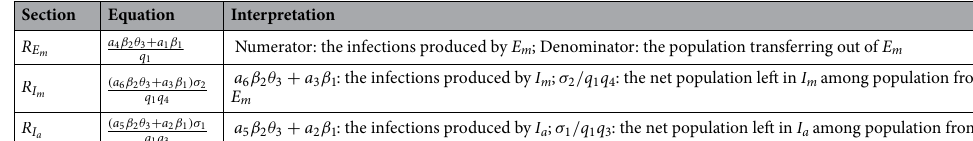
Table 1. Interpretation of the basic reproduction number R 0